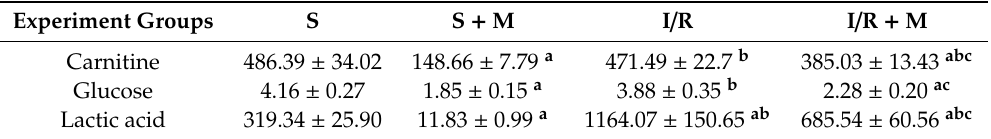
Table1. Kidneycarnitine, glucose, andlacticacidconcentration( µ g / gwettissuemass).